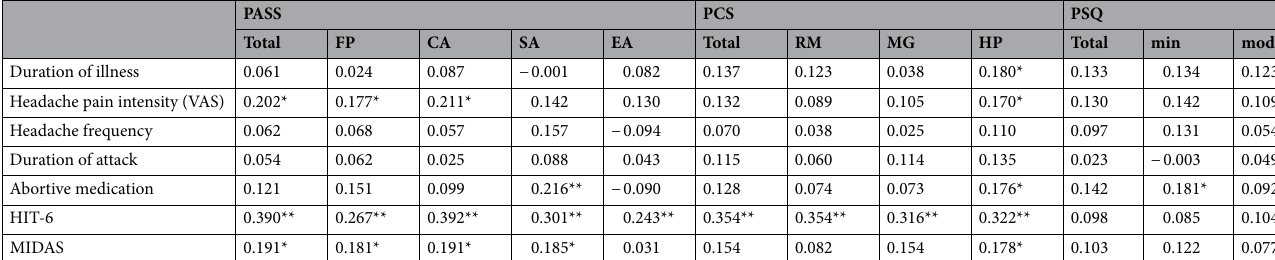
Table 3. The relationship between emotional and the cognitive aspect of pain perception and migraine characteristics and headache-related disability. Pearson’s correlation coefficients and p value are shown